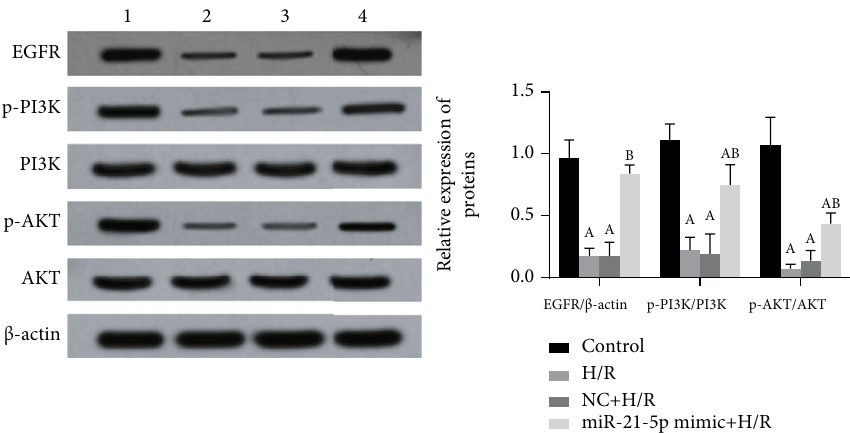
Figure 4: The e ff ects of miR-21-5p overexpression on the activation of the EGFR/PI3K/AKT signaling pathway ( n = 3 ). The experimental groups are as follows: 1: control group; 2: H/R group; 3: NC+H/R group; 4: miR-21-5p mimic+H/R group. Note: Student ’ s t -test was used. Compared with the control group, a P < 0 : 05 ; compared with the H/R group, b P < 0 : 05